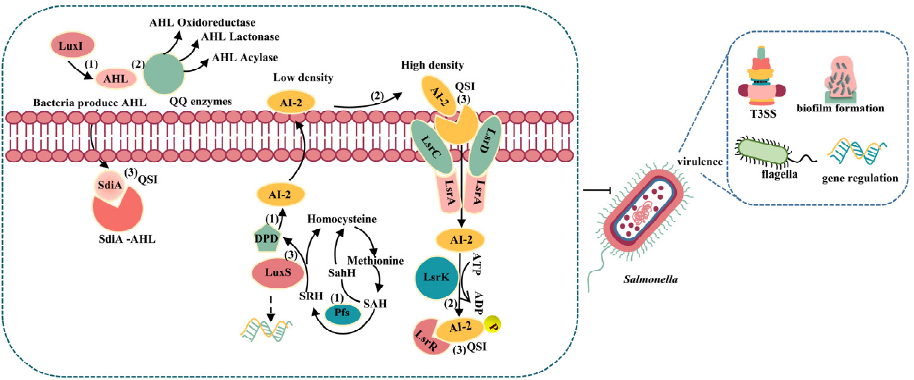
Figure 2. Strategies for QS interception. Strategies of QS inhibiting agents are marked with numbers on the diagram: (1) inhibit AIs synthesis; (2) inactivate AIs and degrade the enzyme of AIs; and (3) interfere with the AIs receptors.